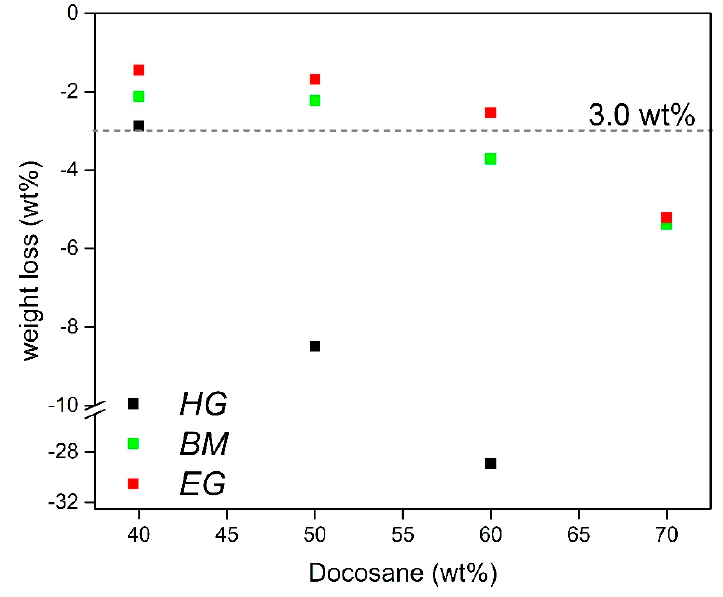
Figure 5. Weight loss of composites at 70 °C attributed to the leakage of Docosane.